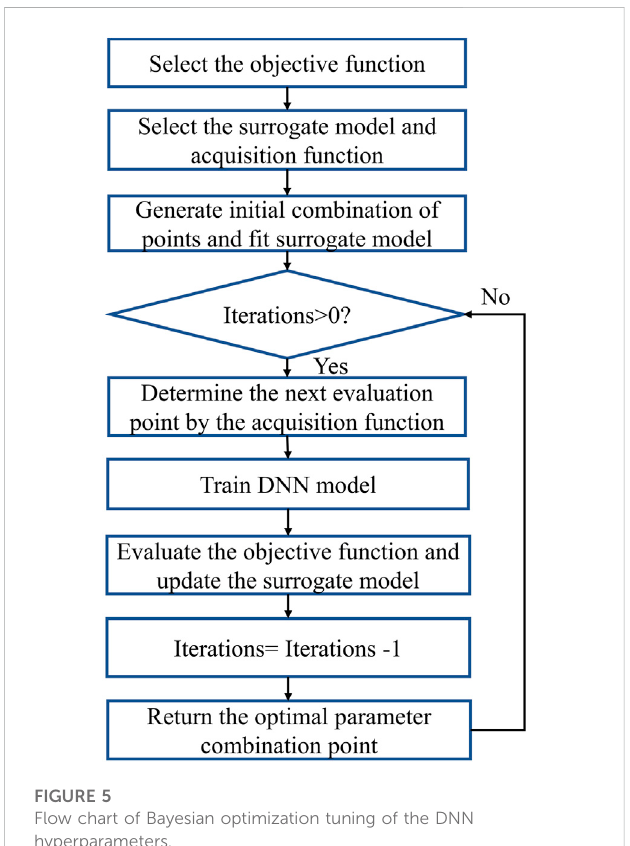
FIGURE 5 Flow chart of Bayesian optimization tuning of the DNN